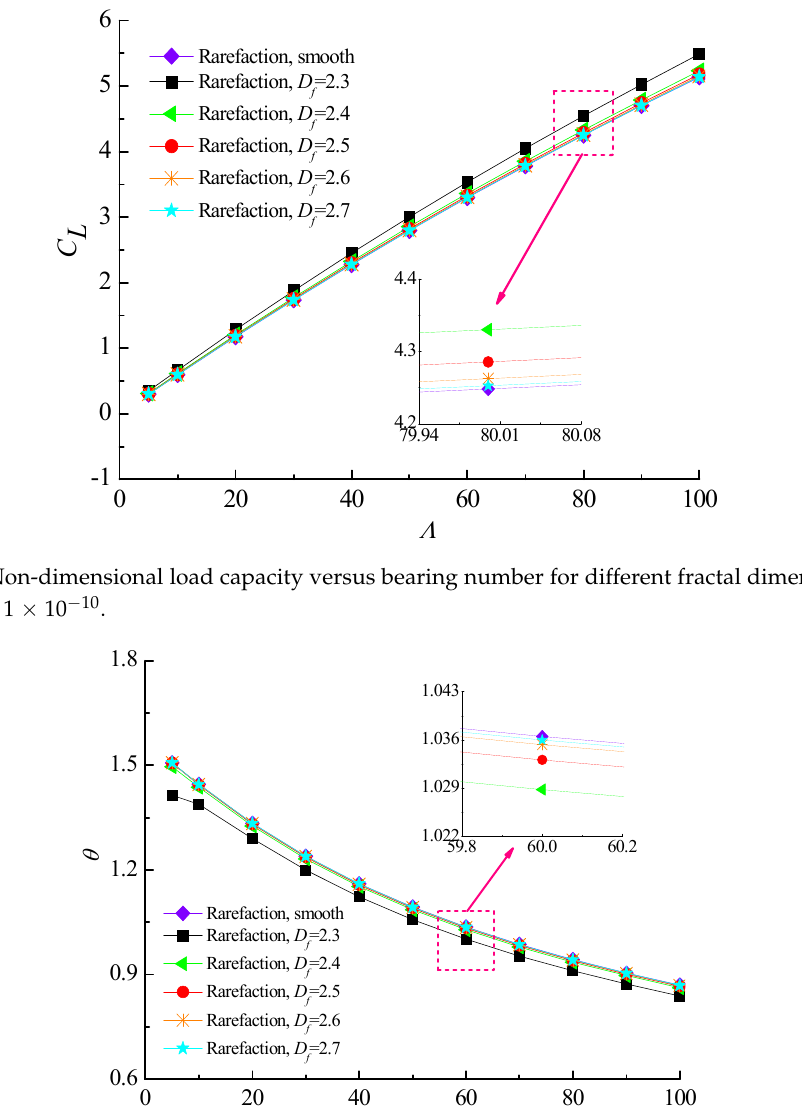
Figure 8. Static friction coefficient versus eccentricity ratio for different fractal dimensions at Λ = 20, G = 1 × 10 −11 .